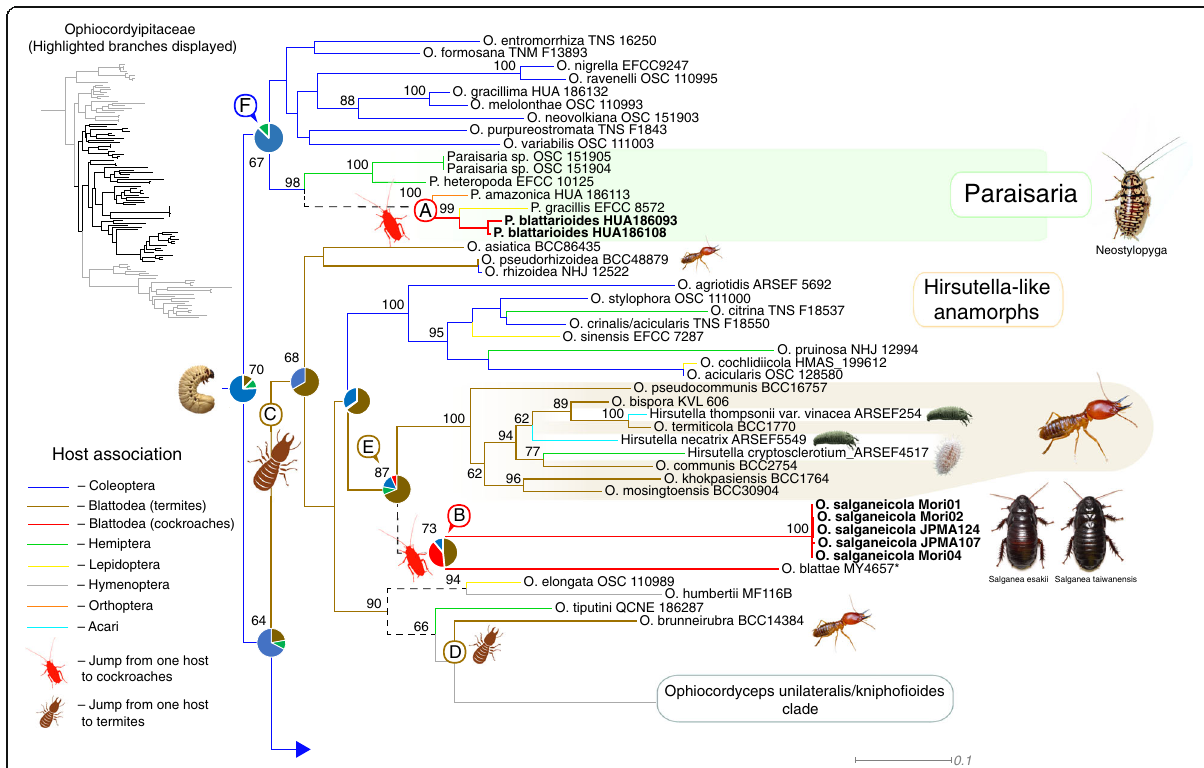
Fig. 5 Maximum likelihood tree of Ophiocordycipitaceae obtained from RAxML analyses based on a concatenated set of 5 genes (SSU, LSU, TEF, RPB1 and RPB2). Colored branches reflect Ancestral Character State Reconstruction (ACSR) analyses based on host associations (See legend at the bottom-left) and pie-charts represent the probability for the association with host orders. Dashed lines indicate ambiguous association. Host pictures by Alex Wild and Shizuma